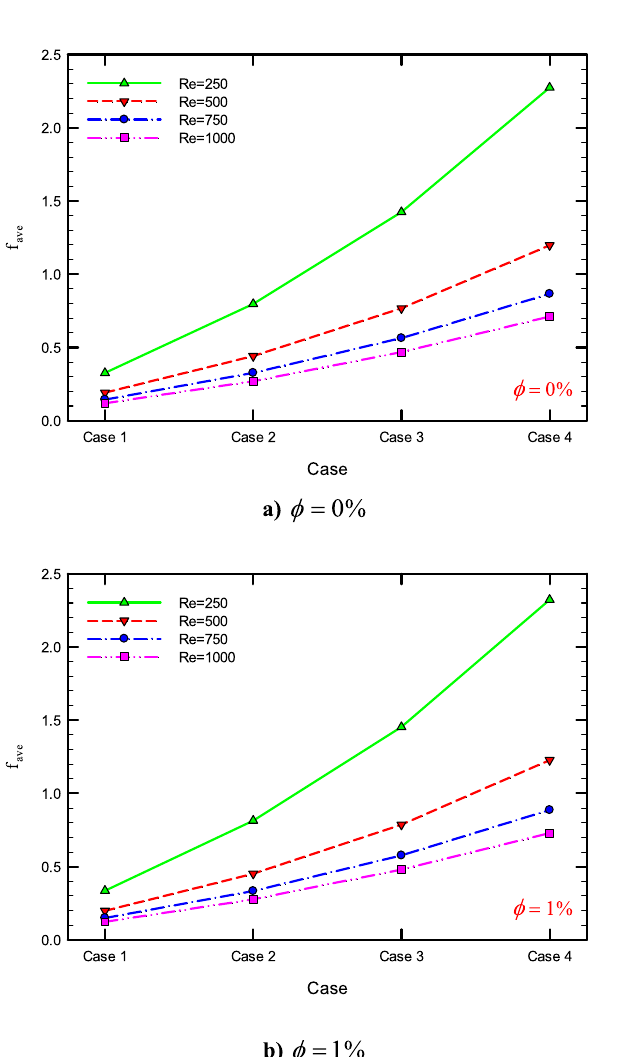
Figure 45. f ave for different cases